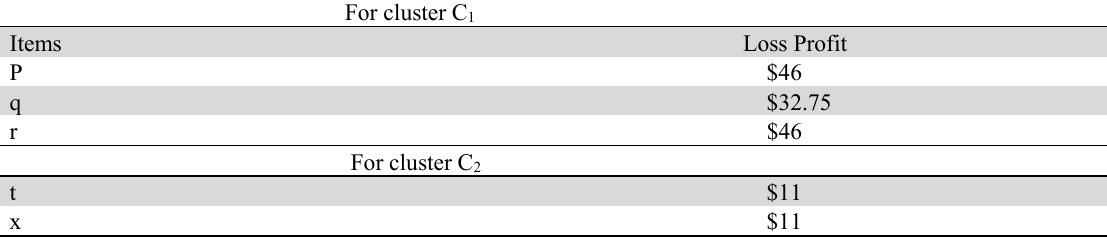
Loss-profit of frequent items in different clusters